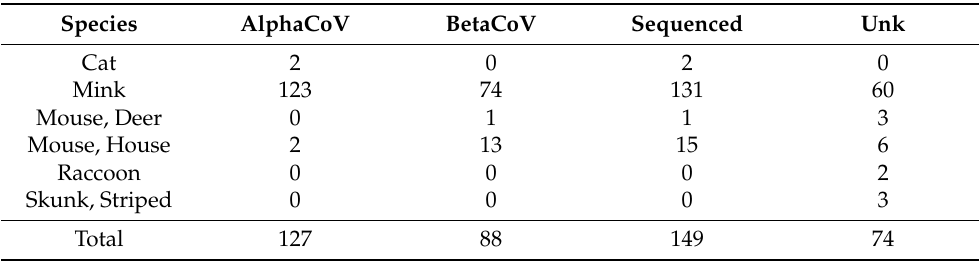
Table 3. Summary of coronaviruses identified. The distribution of coronaviruses detected and characterized according to their host is listed. Species, common name of animal species tested; Al- phaCoV, number of alphacoronaviruses identified; BetaCoV, number of betacoronaviruses identified; Sequenced, number of viruses identified by sequencing, Unchar, number of coronavirus-positive samples not further